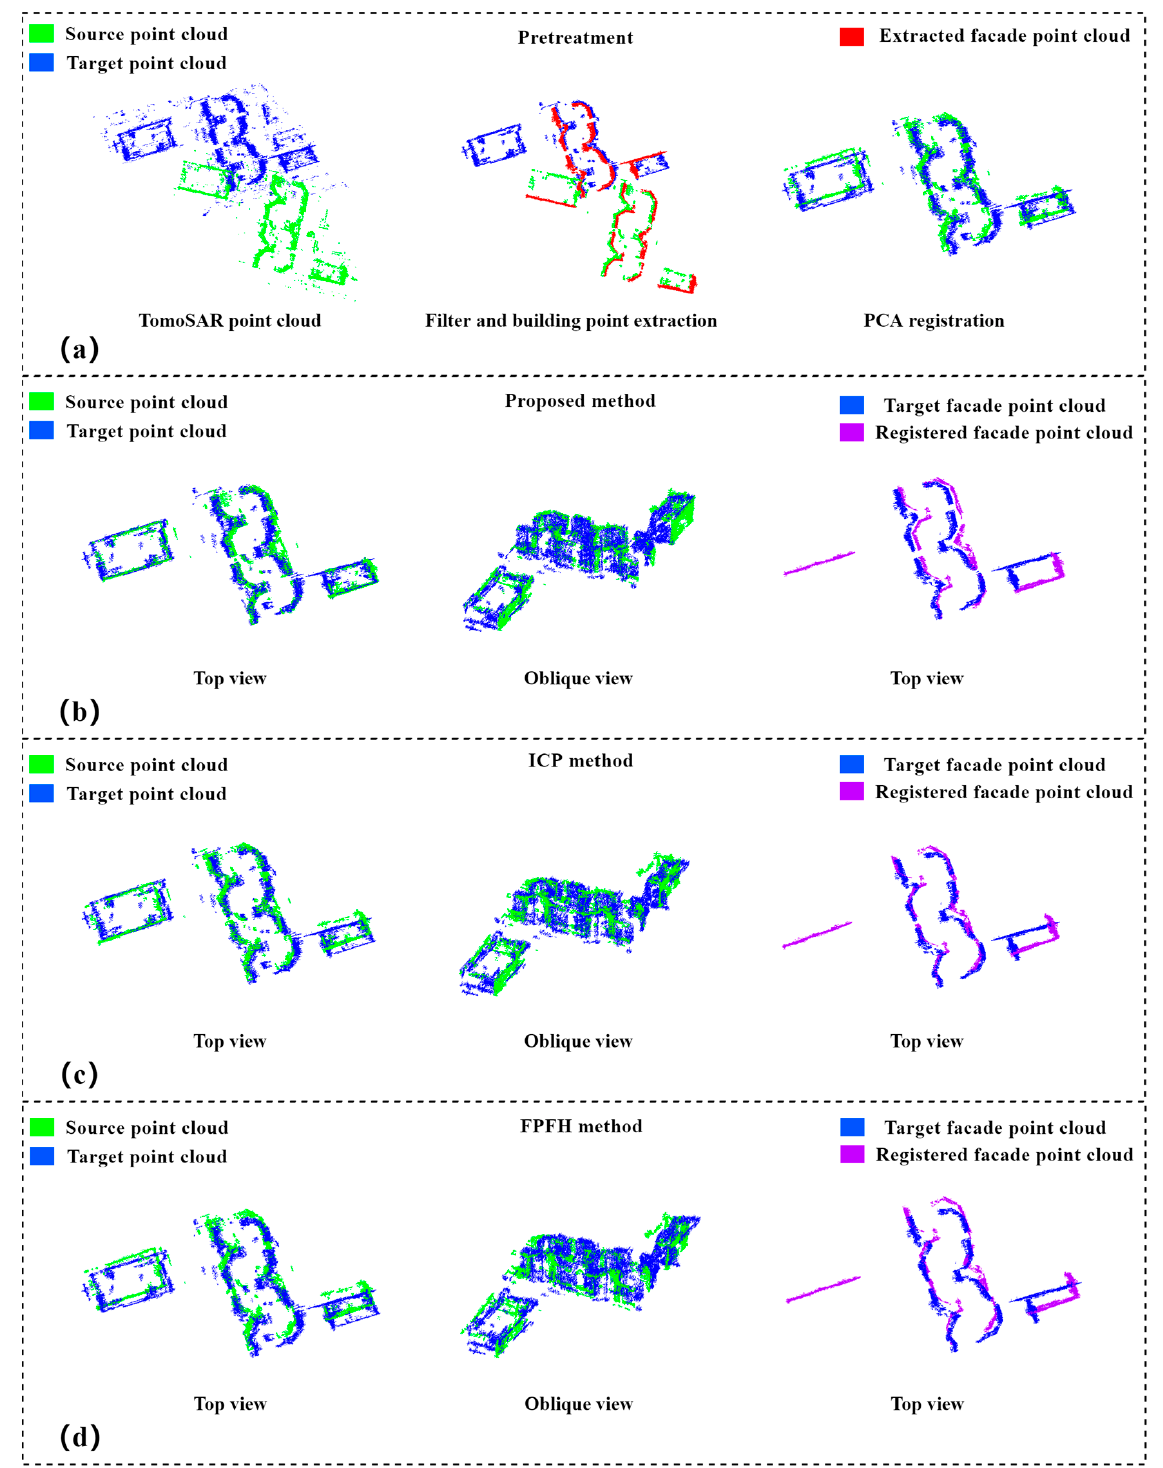
Figure 11. Alignment results of homologous TomoSAR point cloud in Experiment 2: ( a ) preprocessing of raw and experimental data, including statistical filtering, DoPP-based extraction of elevation points, density clustering, and PCA-based coarse alignment; ( b ) top and oblique views of the alignment results of the method in this paper and top view of the aligned facade points; ( c ) top and oblique views of the alignment results of ICP algorithm and top view of the aligned facade points; ( d ) top and oblique views of the alignment results of FPFH algorithm and top view of the aligned facade points. Table 2. Alignment accuracy parameters of Experiment 2.